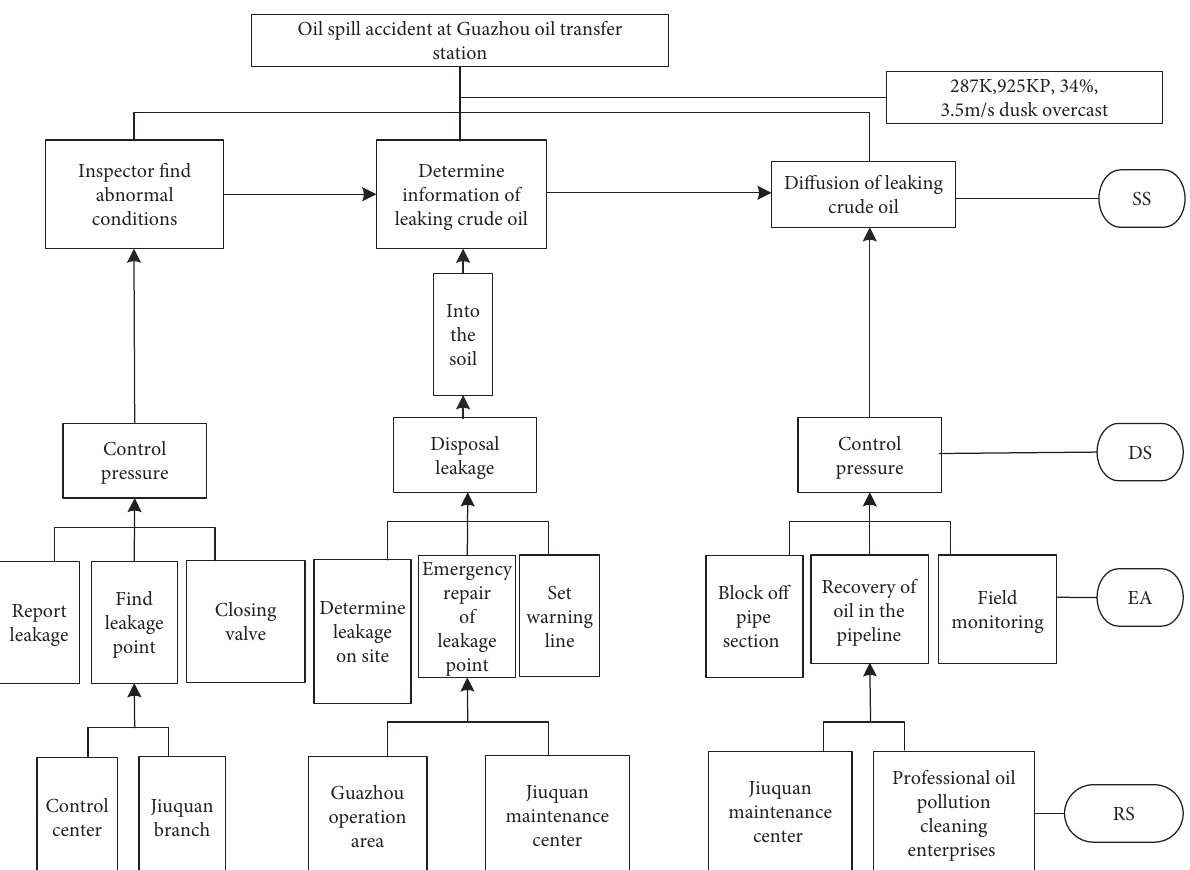
Figure 4: Scenarios of the oil spill accident at Guazhou oil transfer